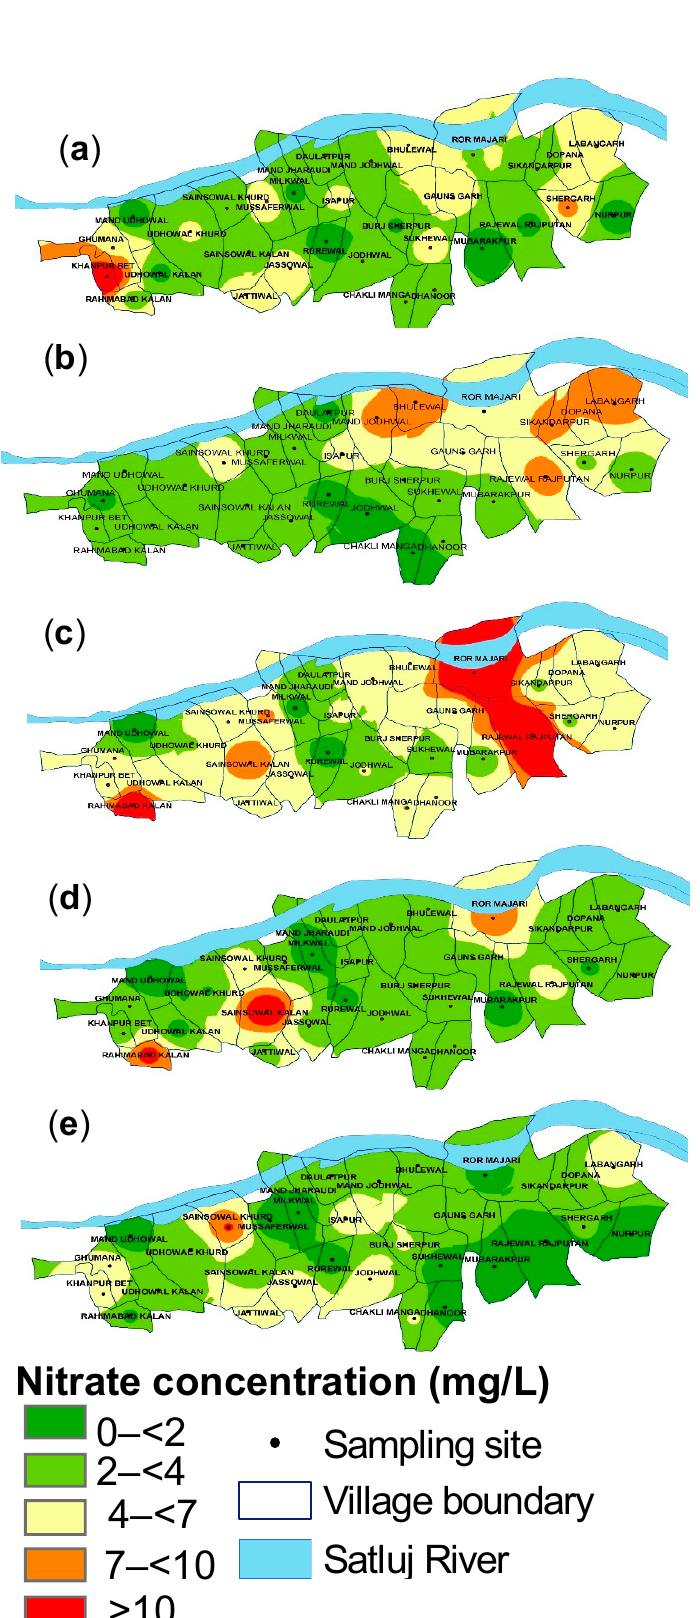
Figure 2. Spatial variability maps of nitrate concentration in groundwater (mg/L) during 2004 rice season ( a ) Jun-20, ( b ) Jun-30, ( c ) Jul-30, ( d ) Aug-31, and ( e ) Sep-30.